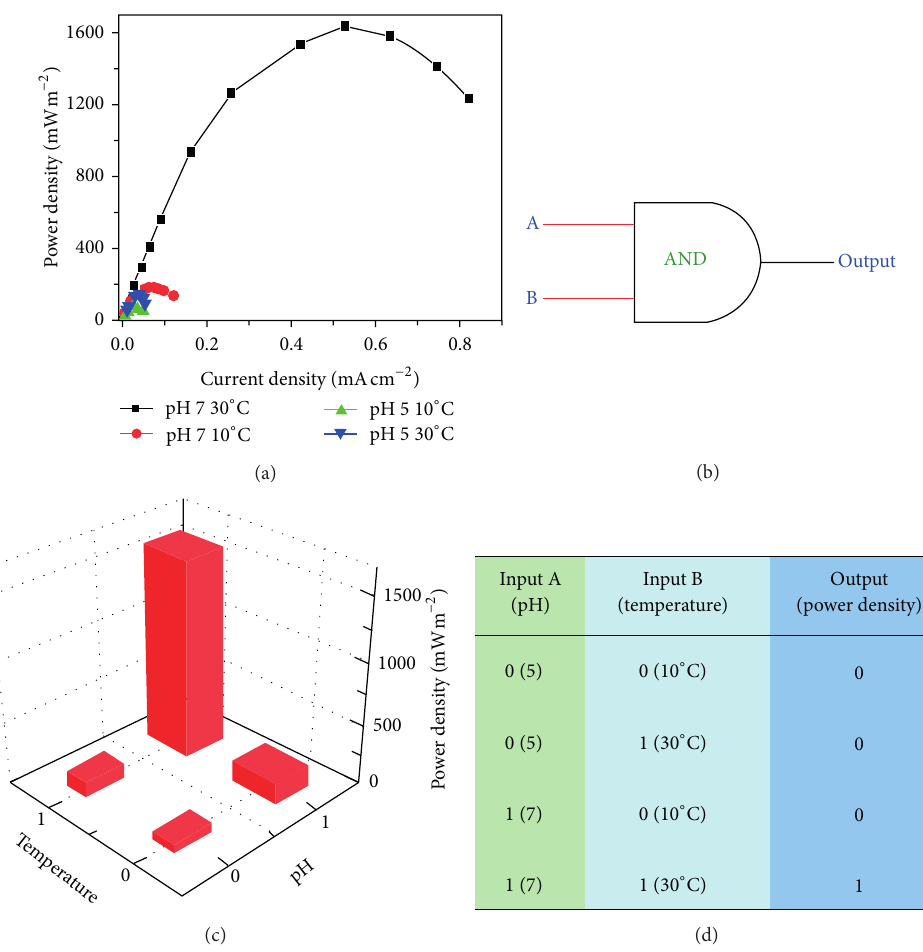
Figure 4: Polarization curves of the MFC under various conditions (a); equivalent circuit of an AND logic gate based on the MFC (b); the maximum power output of the MFC for four different input combinations (c); and truth table for the logically controlled power output